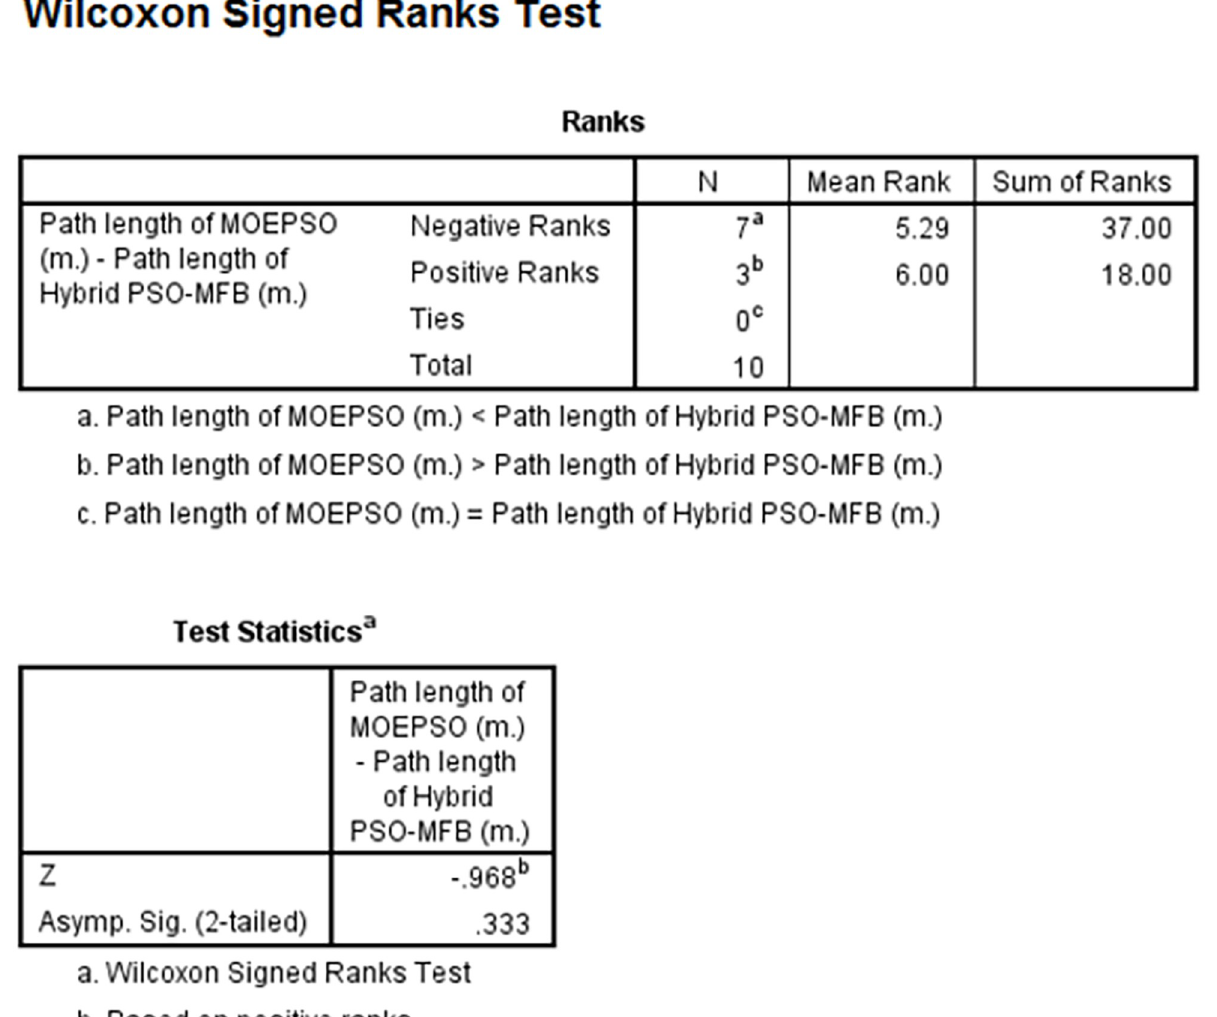
Fig 25. Wilcoxon signed-rank test path length of MOEPSO-path length of Hybrid PSO-MFB.